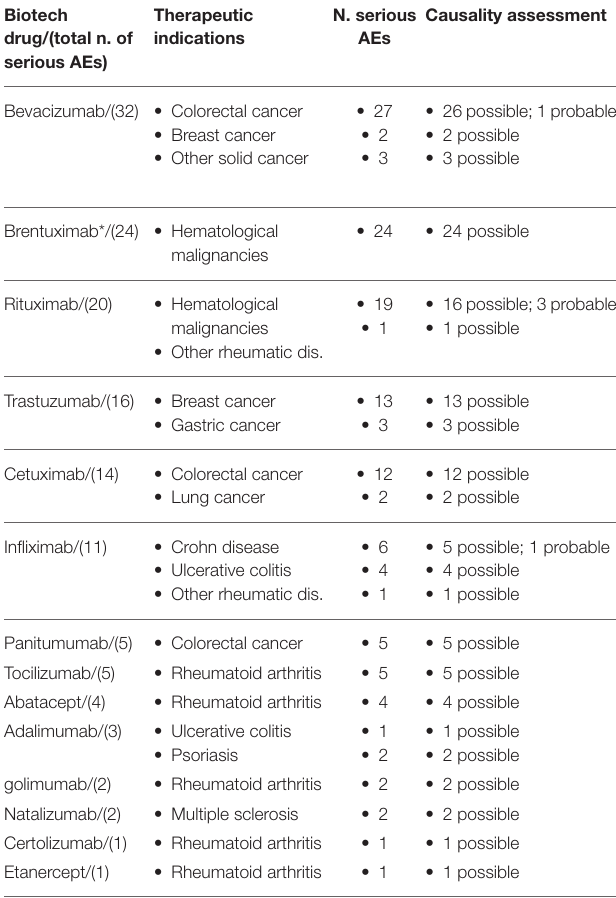
Therapeutic indications